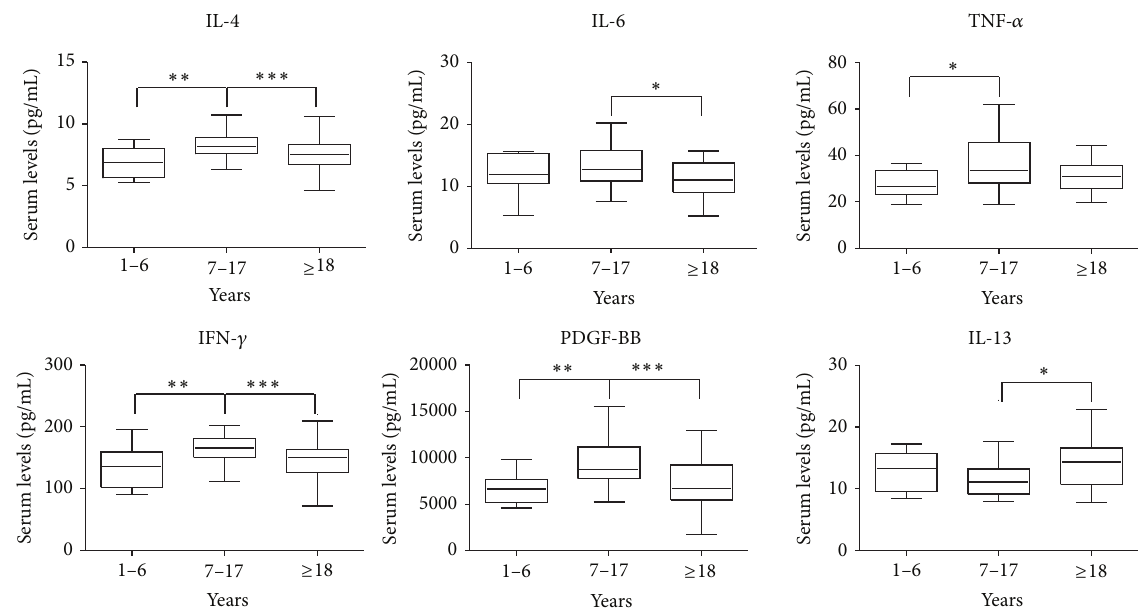
Figure 3: Box plots of serum levels (pg/mL) of cytokines IL-4, IL-6, TNF- 𝛼 , IFN- 𝛾 , PDGF-BB, and IL-13 for young children (1–6), children (7–17), and adults ( ≥ 18). Whiskers calculated adopting the Tukey method. Outliers not shown. ∗ 𝑃 < 0.05 , ∗∗ 𝑃 < 0.01 , ∗∗∗ 𝑃 < 0.001 : Kruskal- Wallis test followed by Dunn’s multiple comparison